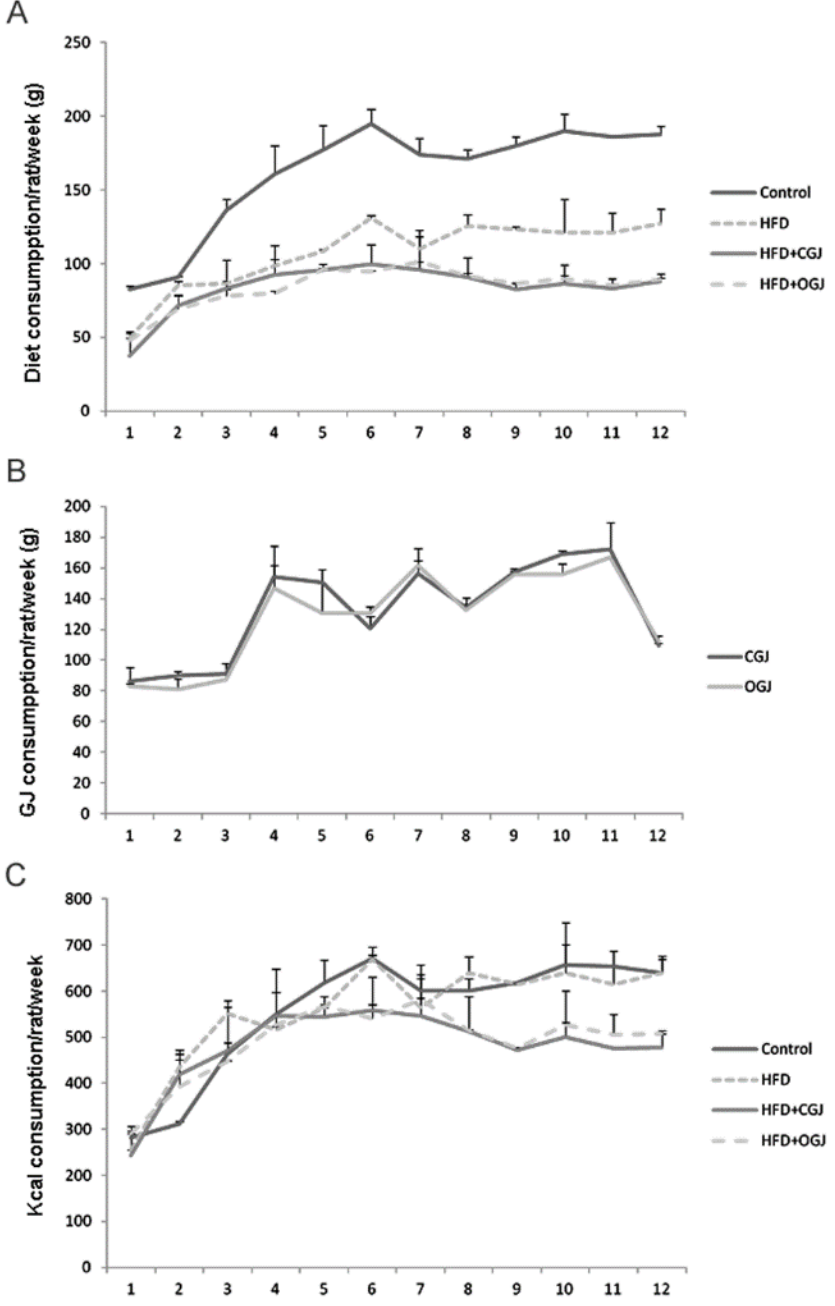
Figure 1. Food consumption/rat/week ( A ), grape juice consumption/rat/week ( B ), and energy intake consumption/rat/week ( C ) during the 12 weeks of treatment. Data are reported as means ± SEM for ten animals per group. Repeated-measures ANOVA, followed by Bonferroni test. HFD: high-fat diet; GJ: grape juice; CGJ: conventional grape juice, OGJ: organic grape juice.